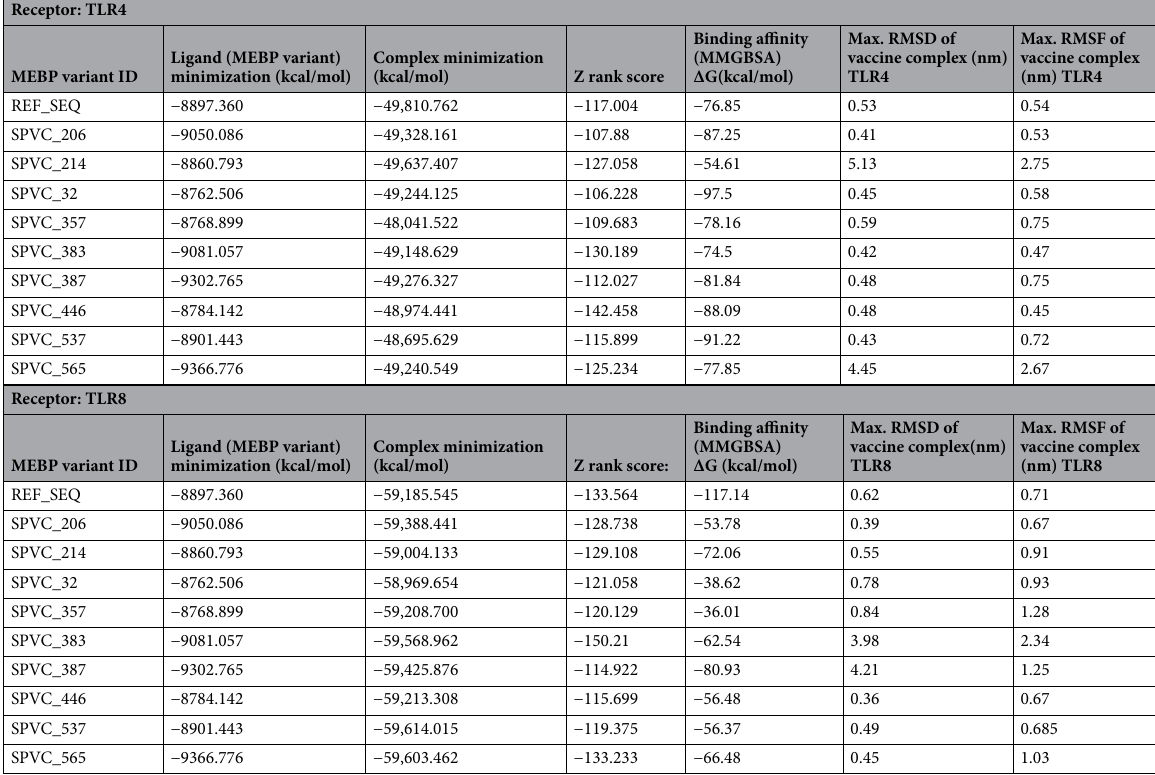
Table 5. Minimization energies, Docking scores, binding affinities (MMGBSA), RMSD and RMSF of MEBP variants with both the receptors (TLR4 and